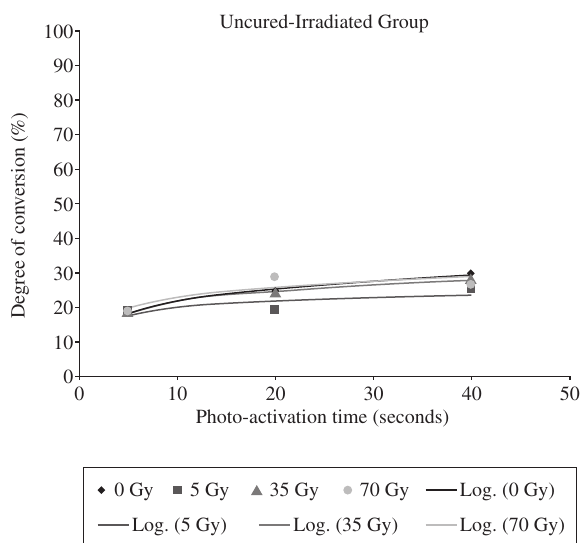
Figure 8. Regression analysis of degree of conversion of the Fill Magic Flow ® material to cured-irradiated groups in accordance with radiation dose as a function of the photo-activation